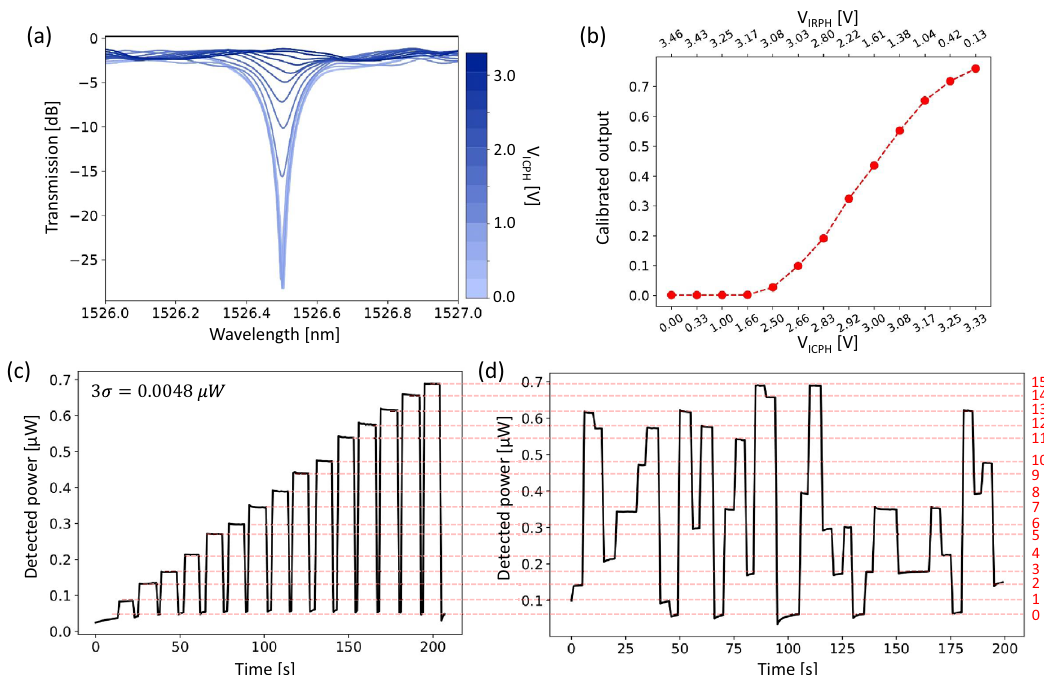
Figure 4. ( a ) Measured transmission spectra after normalization with different V ICPH and V IRPH voltage pairs for intensity modulation operations at 1526.5 nm. ( b ) Calibrated outputs of the IM-MRM at the resonant peak. ( c ) 16 distinguishable power levels in consecutive ascending order with 3 σ = 0.0048 µ W. ( d ) Arbitrary levels reached independently among 16 intermediate